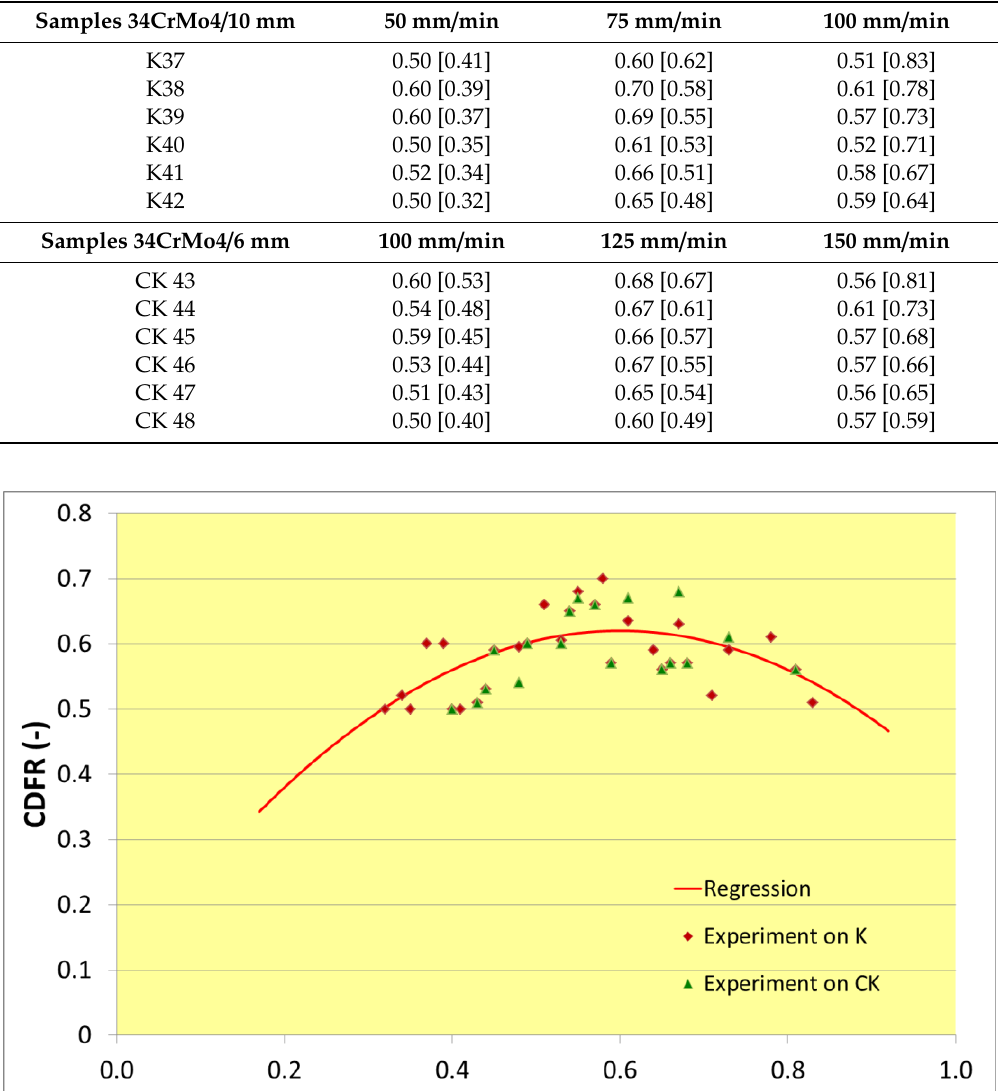
(the heading line of Table 4) and the respective limit traverse speed v P lim2 (see Table 2) calculated for each material from v P lim1 through Equation (4). CDFR values for various relative traverse speeds are